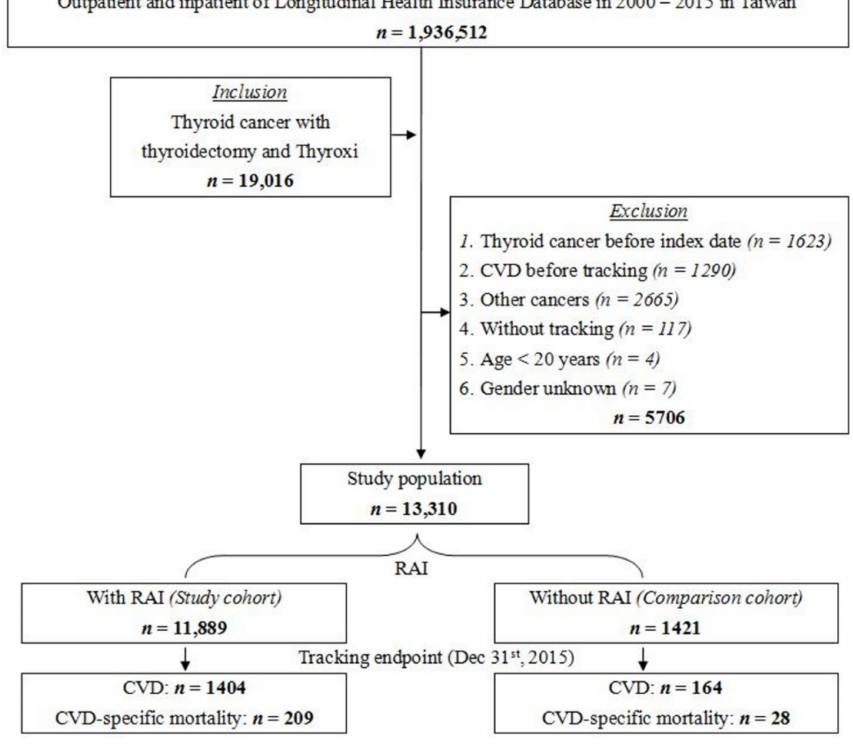
Figure 1. Flowchart of the study